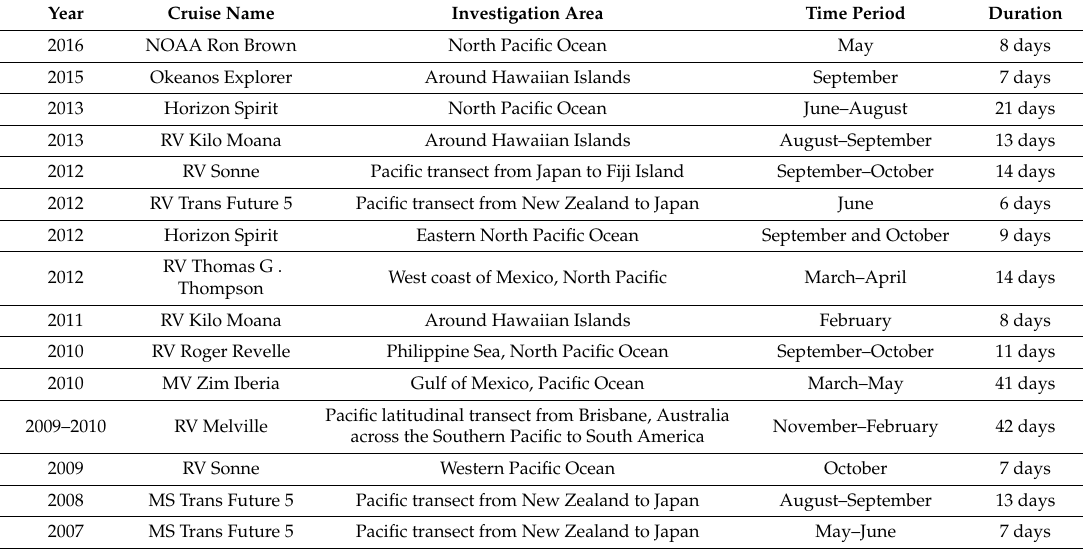
Table 1. List of Maritime Aerosol Network (MAN) cruises, investigation areas, and number of measurement